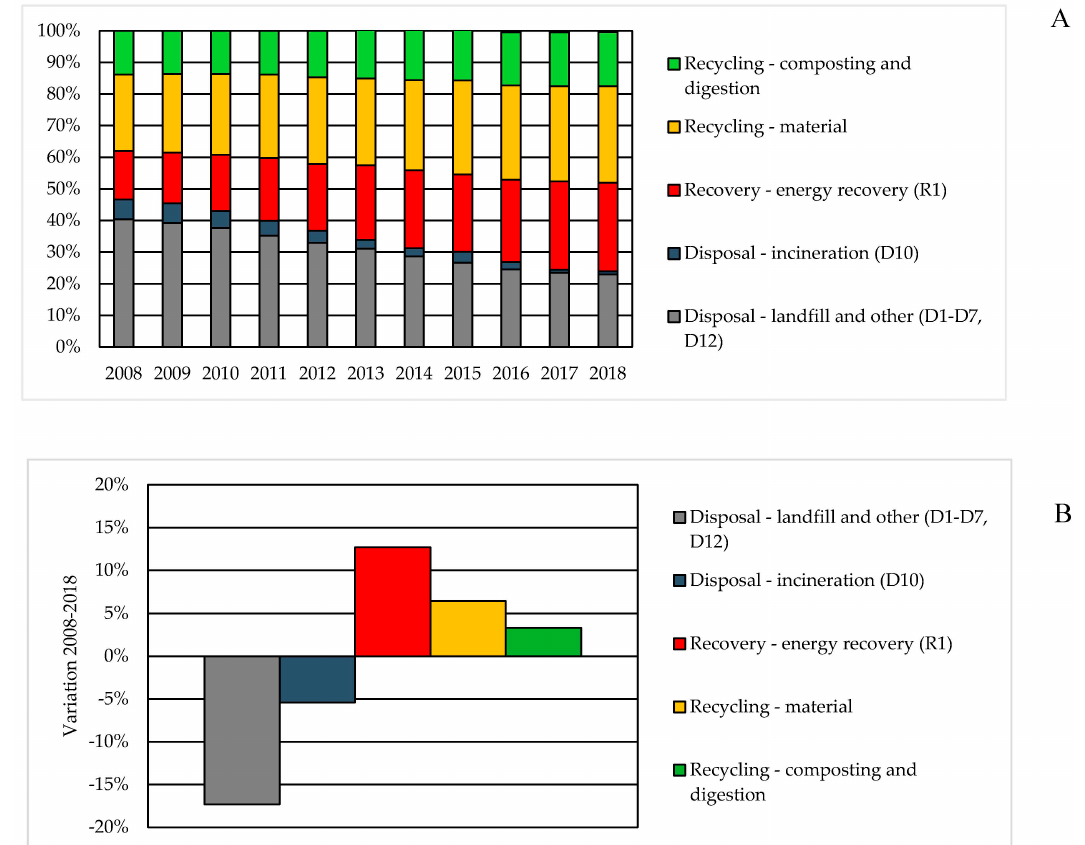
Figure 3. MSW management in EU-28 in 2008–2018: ( A ) historical evolution of waste management operations [1]; ( B ) net % variation of waste management operations between 2018 and 2008.